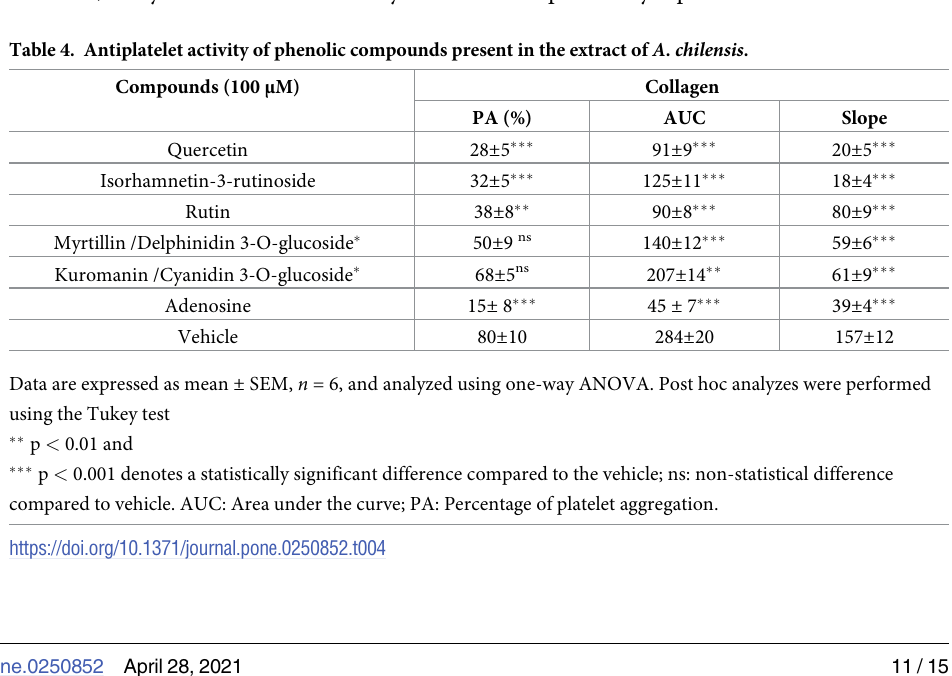
Table 4. Antiplatelet activity of phenolic compounds present in the extract of A . chilensis .